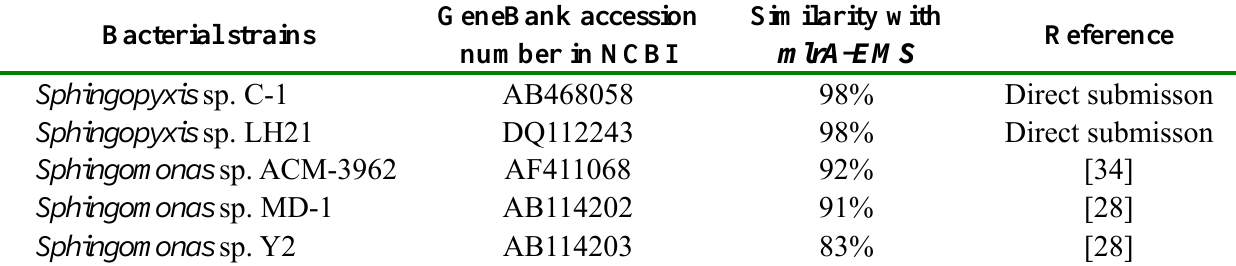
Table 1. Similarities of mlrA-EMS with other reported mlrA genes in DNA